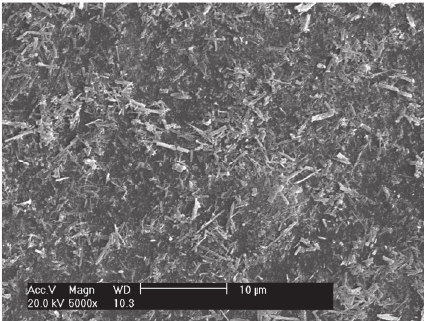
Figure11:SEMspectrumsofimmobilizedPU/TiO 2 afterbeingused